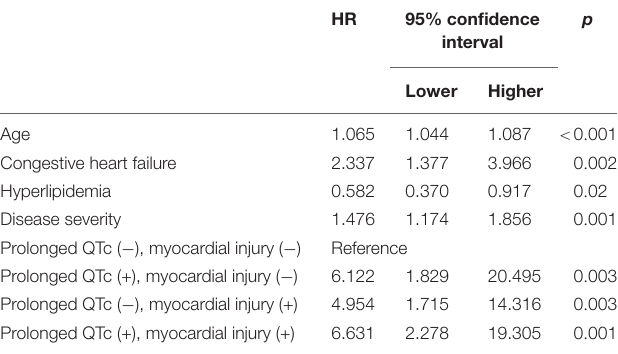
TABLE 4 | Multivariate Cox regression for 1-year mortality stratified by QTc prolongation and myocardial